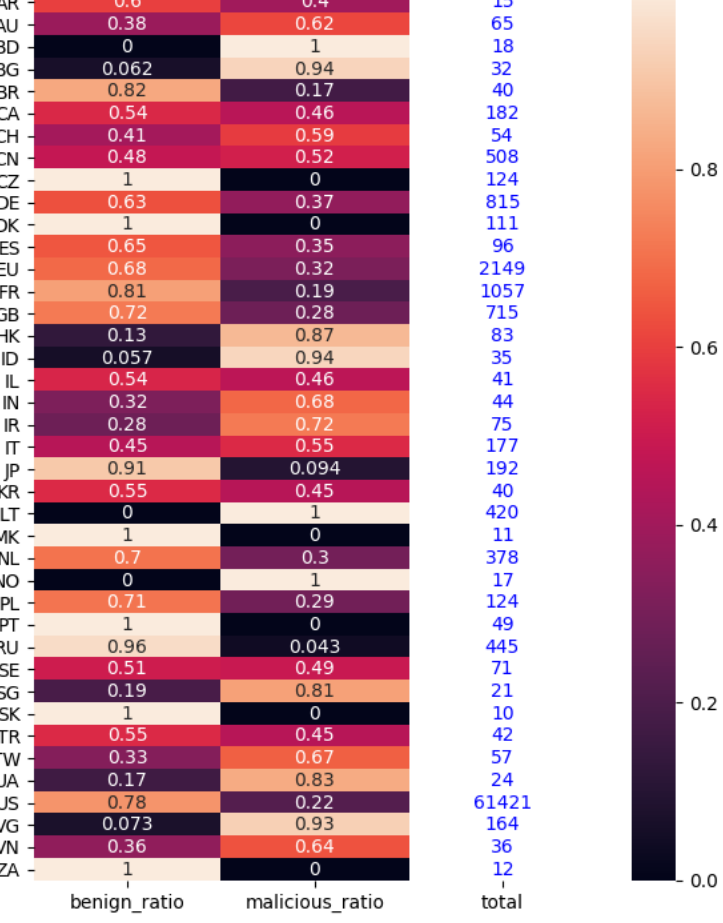
Figure 4. Communication countries